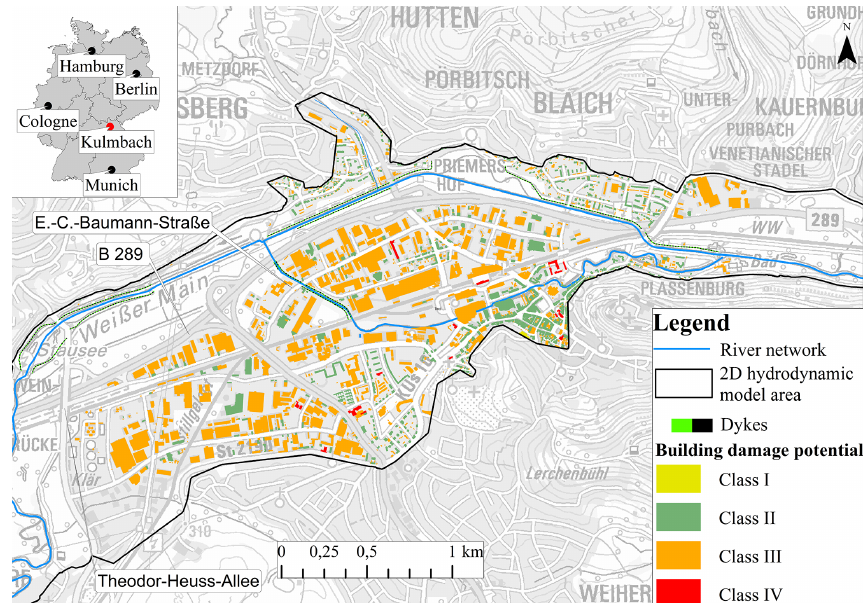
Figure 4. The city of Kulmbach and building damage potential classification. (Data source: Bavarian Ministry of the Interior, for Building and Transport and Water Management Authority Hof; Geobasisdaten © Bayerische Vermessungsverwaltung, http://www.geodaten.bayern.de, last access: 5 March